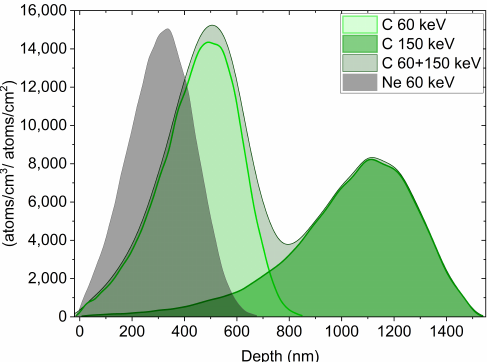
Figure 1. Depth distribution of implanted C and Ne ions in NT arrays obtained with SRIM simula- tions [14]; the ion beam enters at the left side. The target thickness amounts to 1.5 µ m. C ions with 60keV followed by 150keV and Ne ions with 60keV were